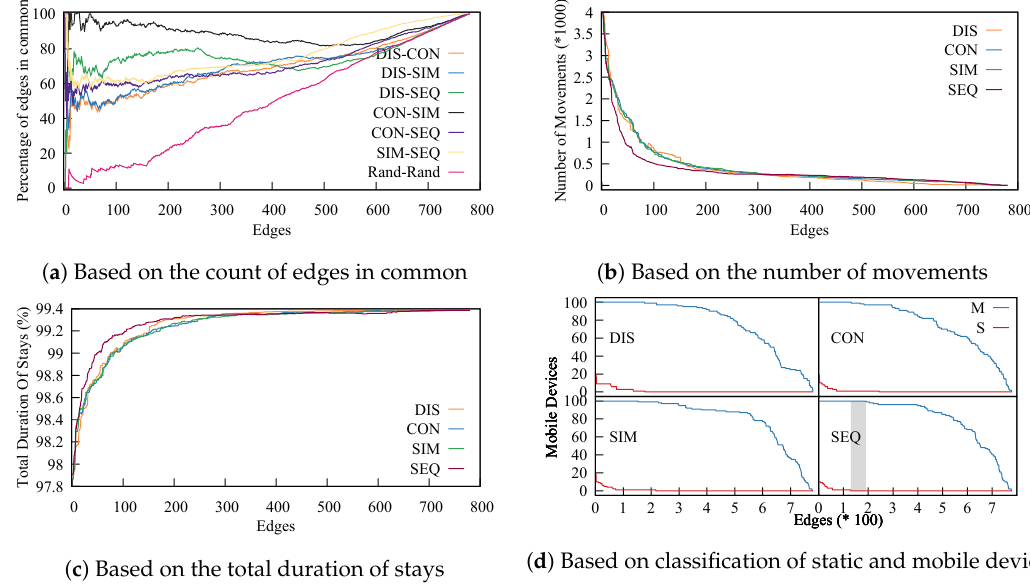
Figure 6. Comparing distance functions and